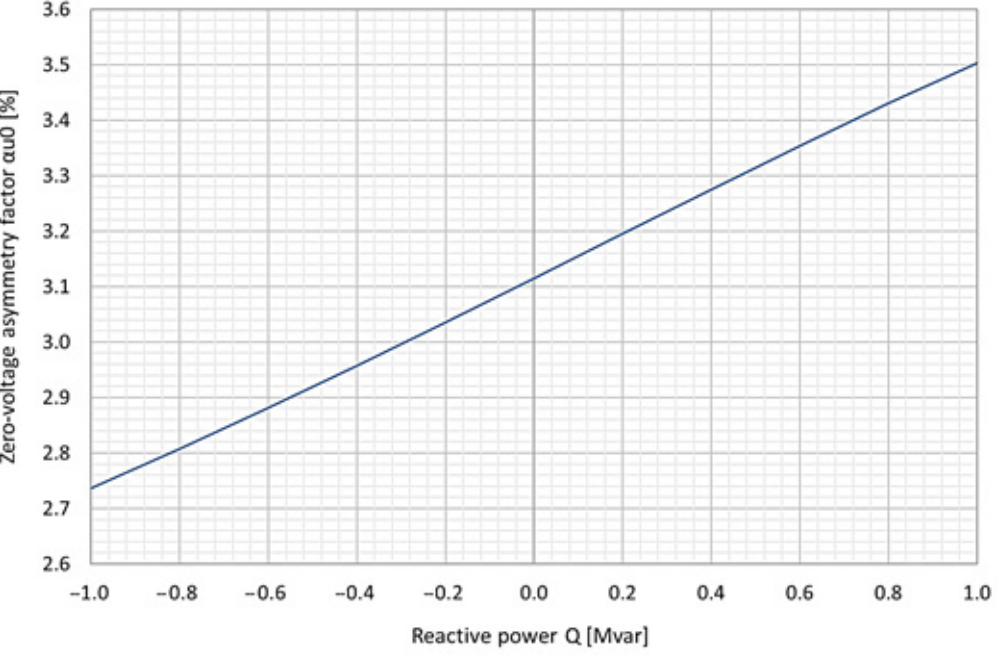
Figure 8. Diagram of the dependence of the zero-voltage asymmetry factor ( α u0% ) on the reactive power of the load (Q), determined by the analytical method.